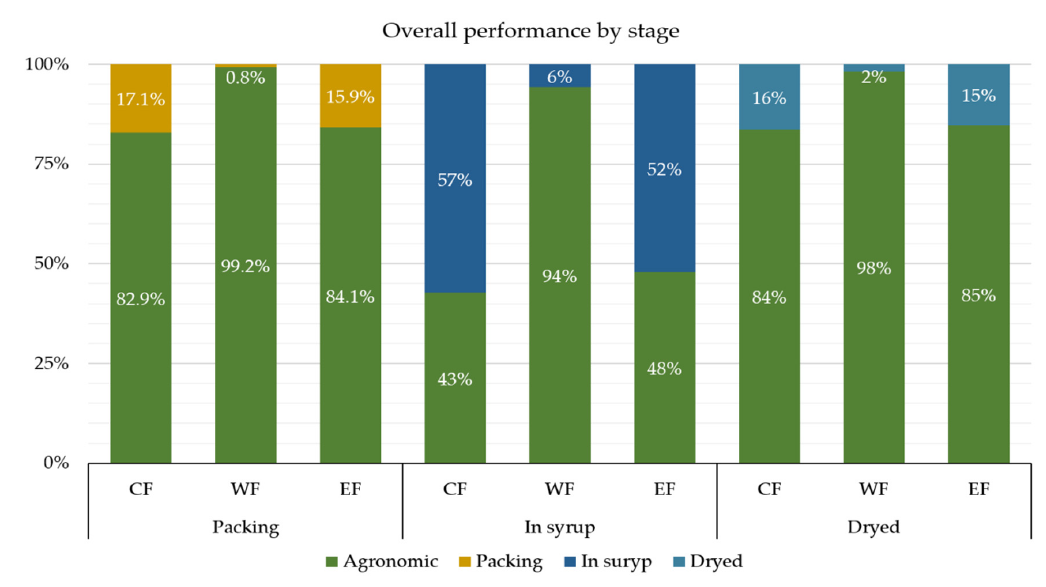
Figure 7. Global environmental impacts by stage and type of industry.